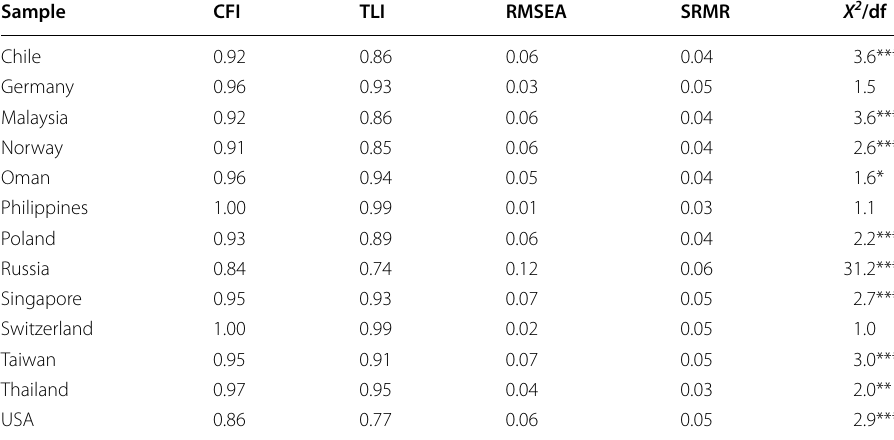
Table 2 Fit of the country specific measurement